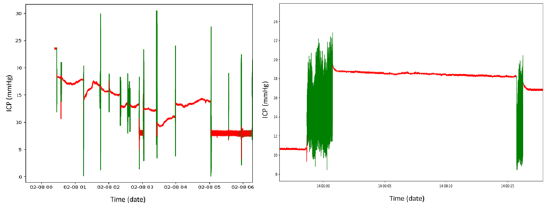
Fig. 1 Results of real‑time ICP signal classification with the KNN algo‑ rithm using the sliding‑window approach. Green: reliable ICP. Red: non‑ reliable ICP (ventricular drain system opened for fluid